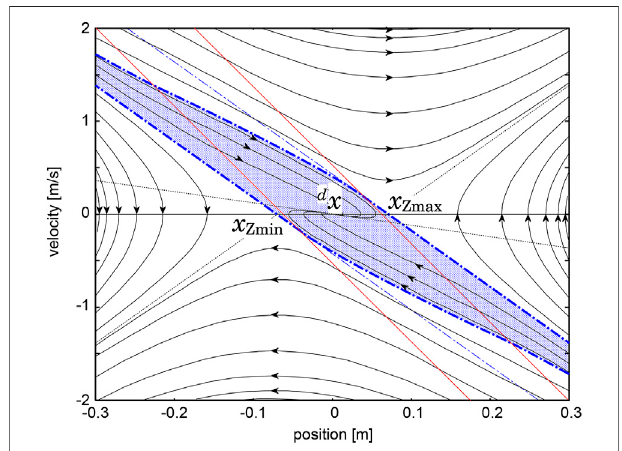
FIGURE 2 | Theoretical phase portrait of the COM-ZMP regulator represented by Eqs 1 , 3 , 4 with ζ (cid:1)